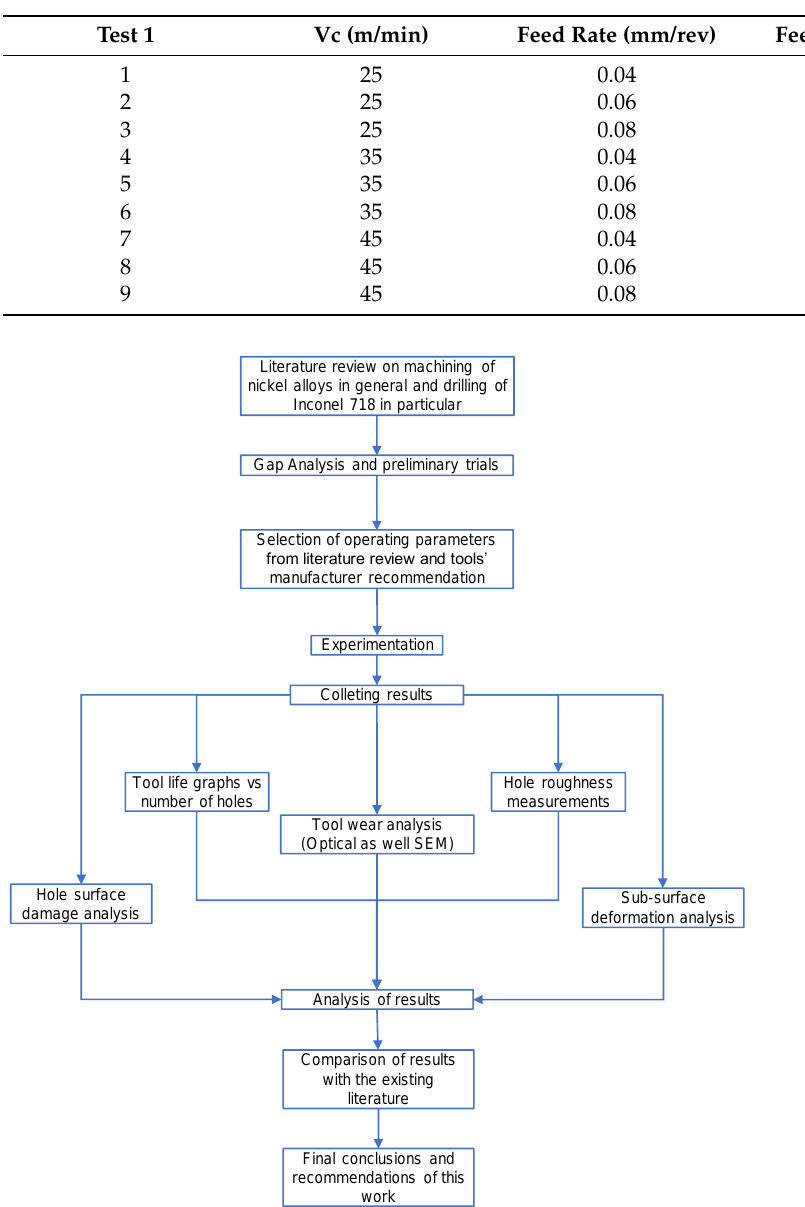
Table 4. Design of experiments based on full factorial design.